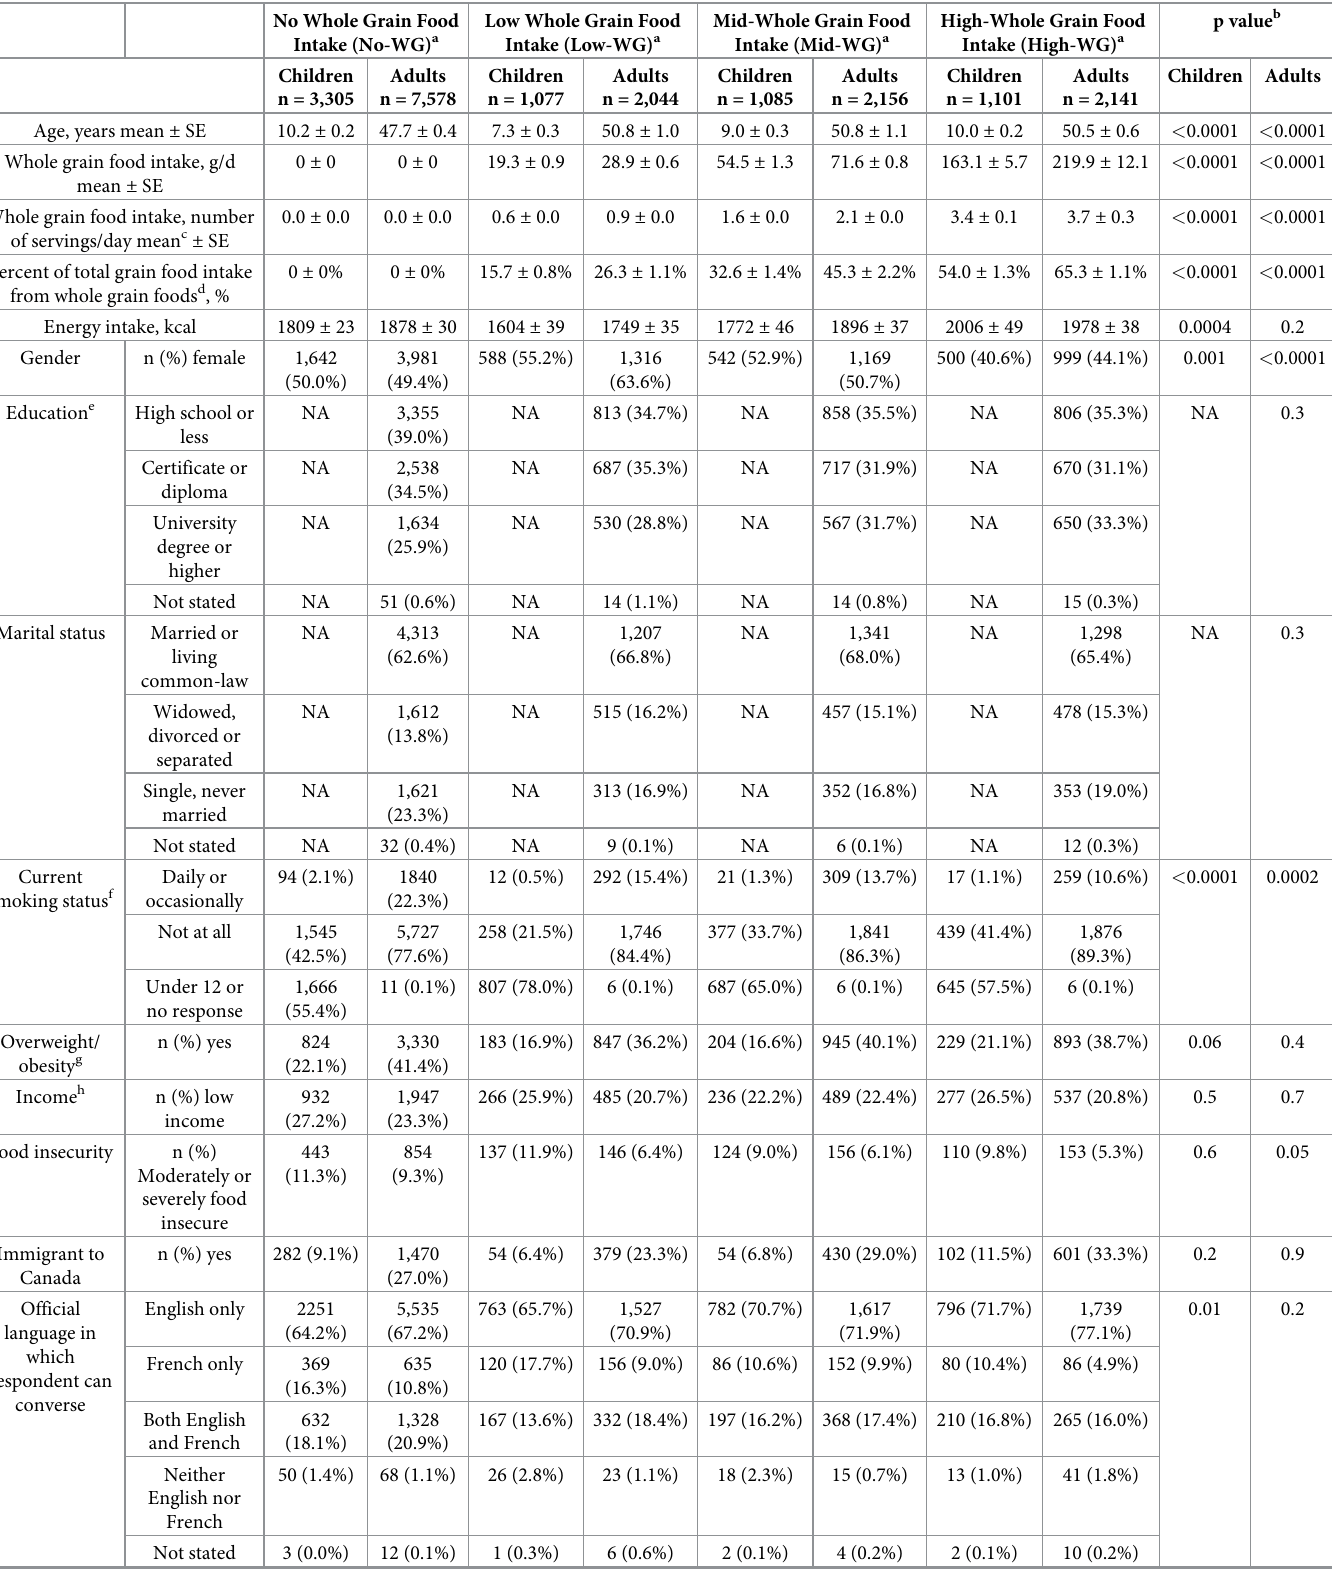
Table 1. Demographic characteristics for Canadian children and adults stratified by whole grain food